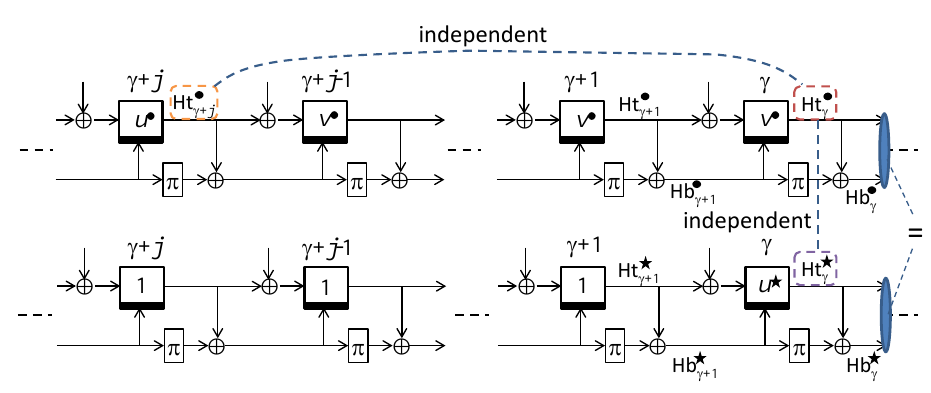
Figure 12: Hash procedures in Case 3, where tweaks for domain separation are in the TRP